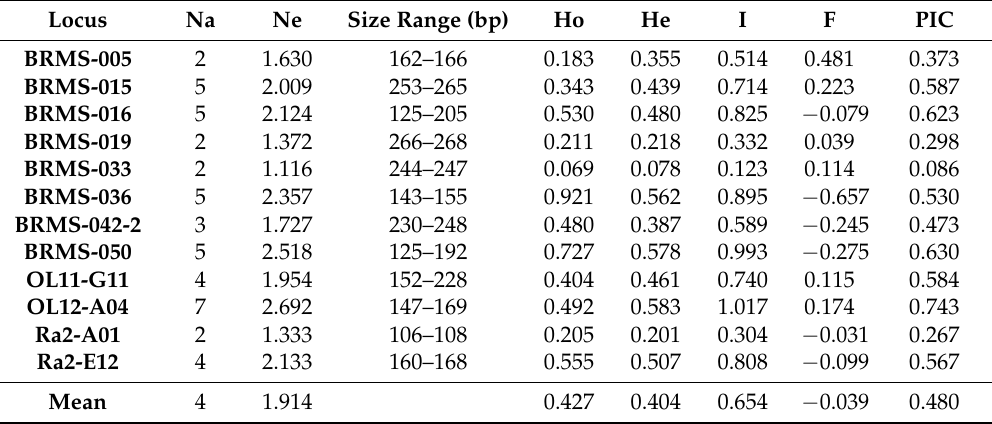
Figure 1. Genetic diversity among Apulian kale accessions characterized in this study, based on their SSR profile. ( a ) Unweighted Pair-Group Method with Arithmetic mean (UPGMA) dendrogram of genetic similarity. Bootstrap support values above 70 are indicated above corresponding nodes; ( b ) principal component analysis (PCoA). Table 1. Genetic diversity indices for individual simple sequence repeat (SSR) markers used in this study. Na: number of alleles; Ne: number of effective alleles; H o : observed heterozygosity; He: expected heterozygosity; I: Shannon’s information index; F: fixation index; and PIC: polymorphic information